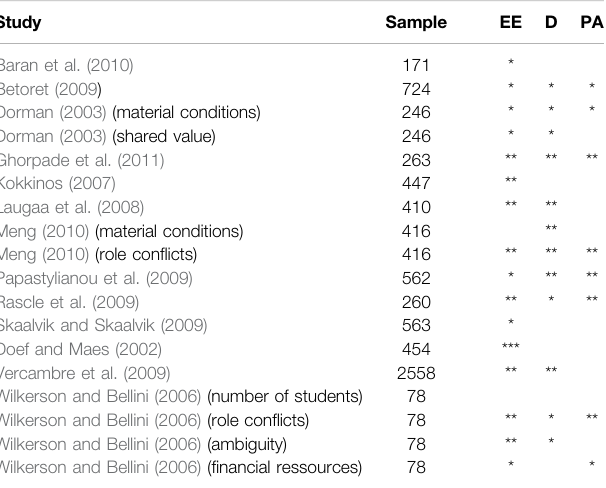
TABLE 1 | School context, work control and burnout.